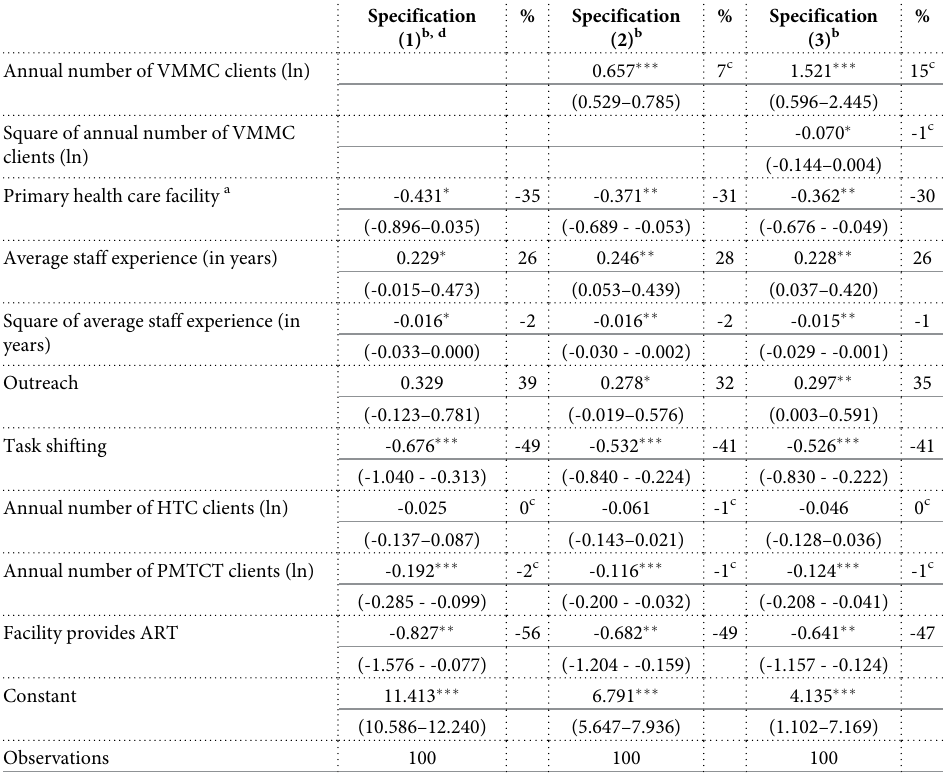
Specification (1) b, d